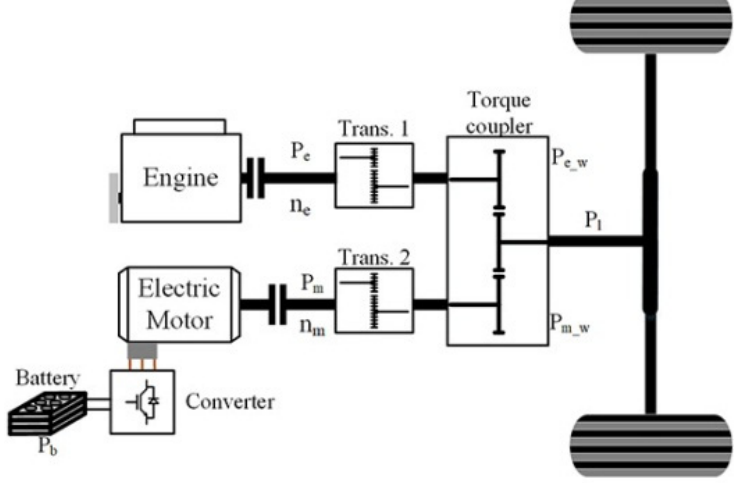
Figure 1. Drivetrain configuration of a torque-coupling parallel HEV. Adapted from Ref. [2].